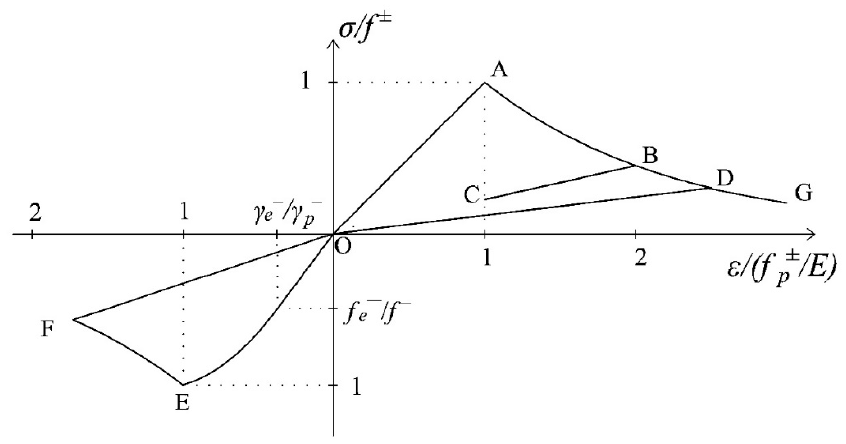
Figure 7. 1D cyclic loading history.